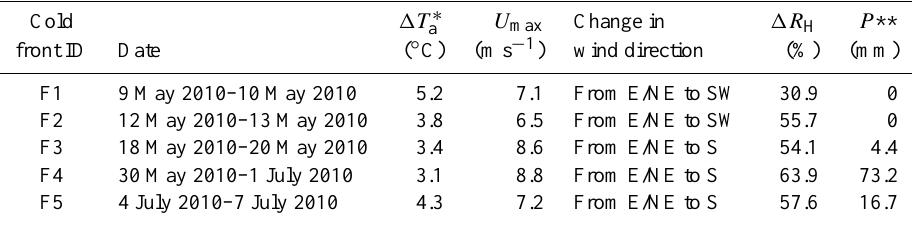
Table 2. Summary of weather conditions during the cold front passages over the Itumbiara Reservoir. Drop in air temperature ( 1T a ) , maximum wind intensity ( U max ) , preferential wind direction, relative humidity variation ( 1R H ) and accumulated precipitation ( P ). Cold